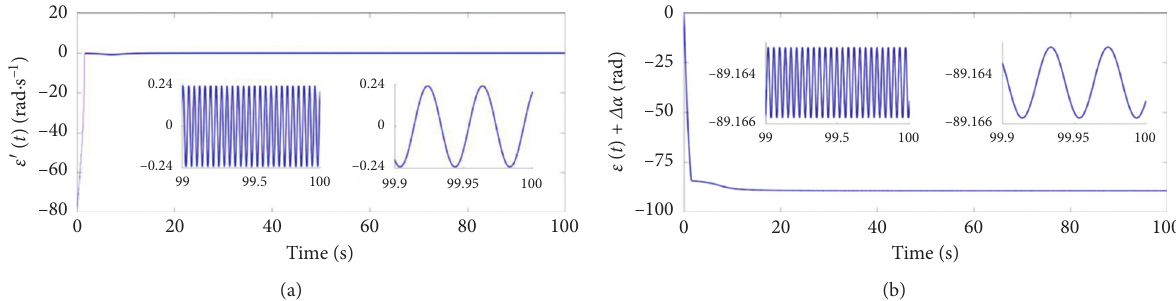
Figure 3: Simulation curve when ω � 25.1 π . (a) ε ′ ( t ) graph. (b) ε ( t ) + Δ α graph.